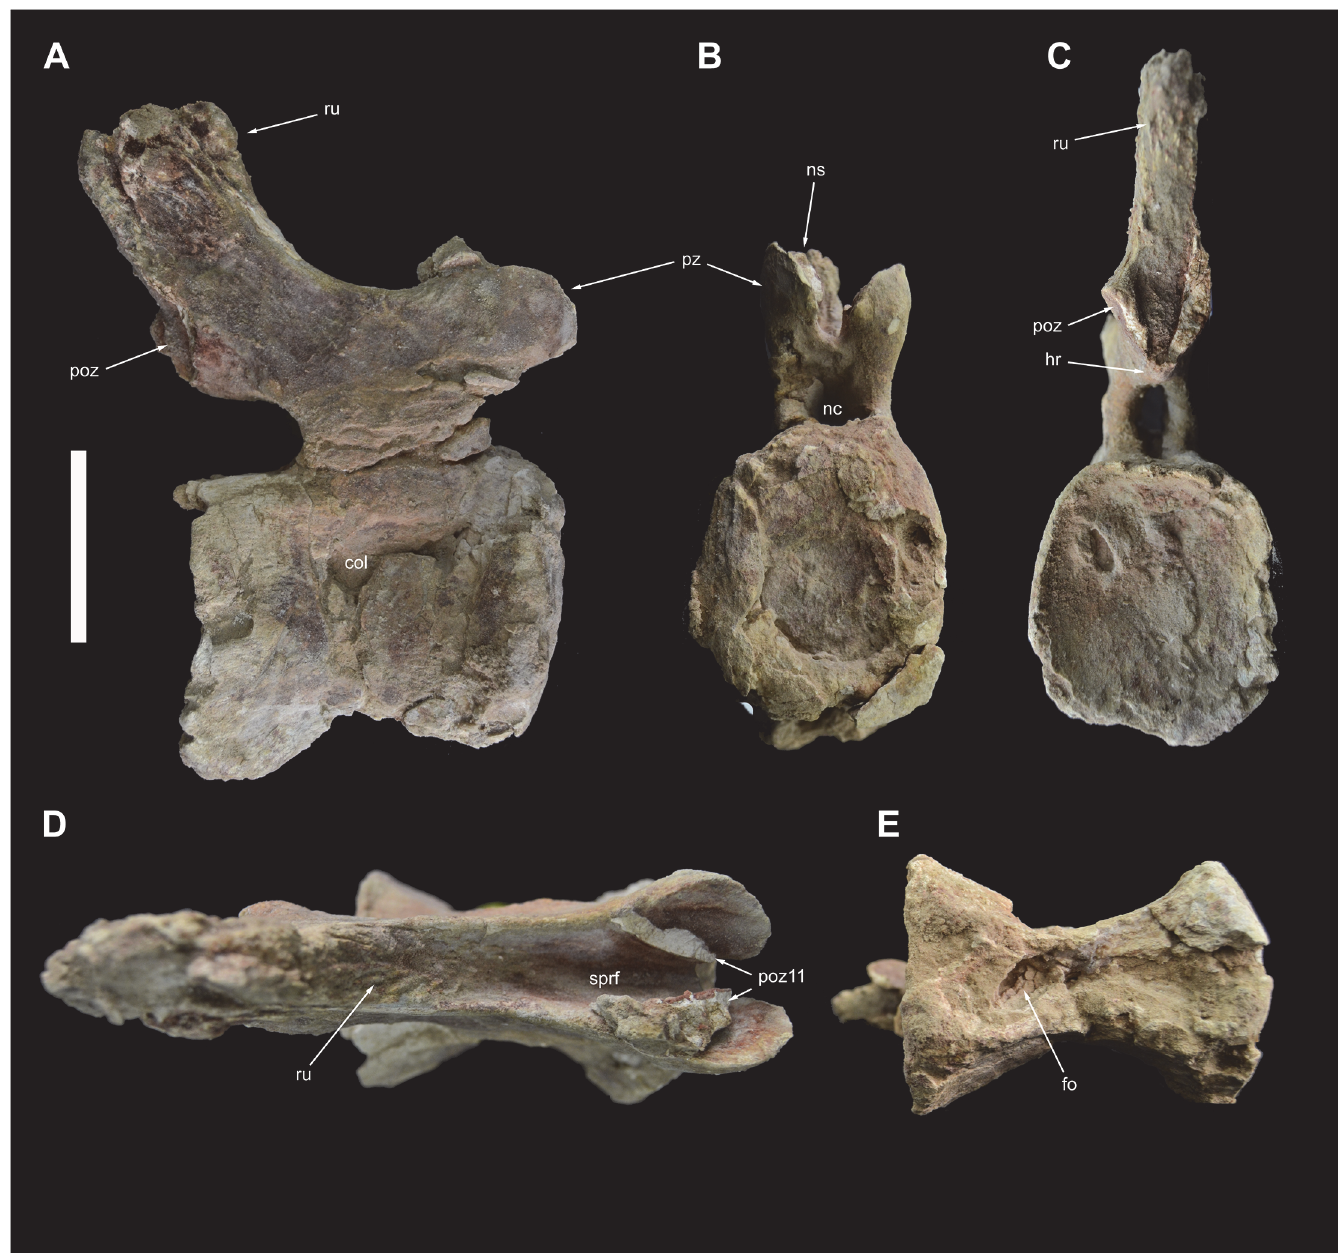
Fig 14. Caudal vertebra 12 of Tataouinea hannibalis . Vertebra in right lateral (A), proximal (B), distal (C), dorsal (D) and ventral (E) views. Scale bar: 10 cm. Abbreviation: fo, fossa; hr, hyposphenal ridge; nc, neural canal; ns, neural spine; poz, postzygapophysis; poz11, fragment of caudal 11 postzygapophysis; pz, prezygapophysis; ru, rugosities; sprf, spinoprezygapophyseal